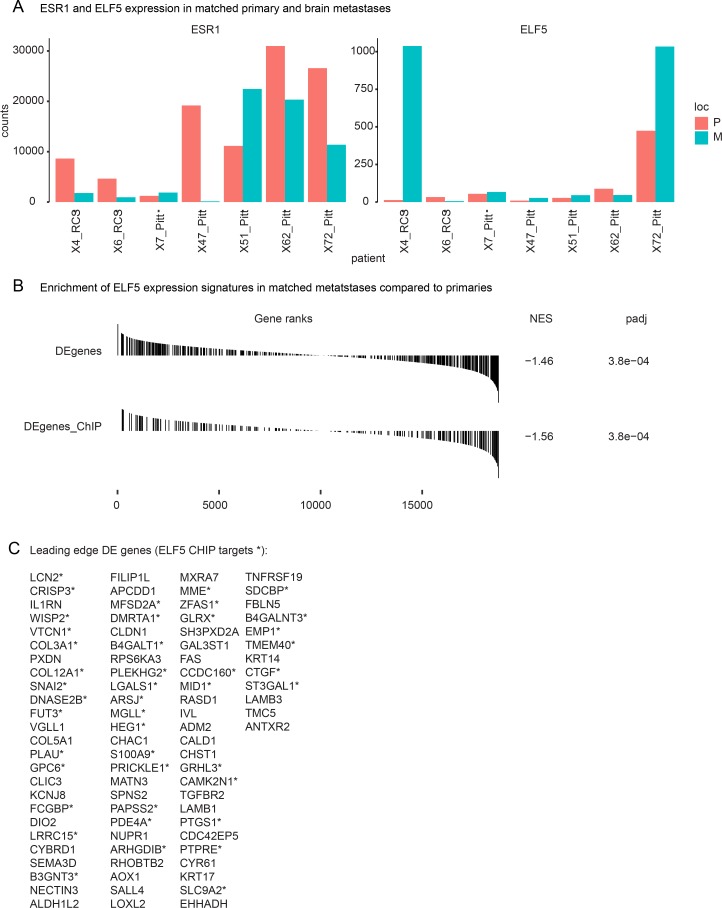
ELF5 expression is increased in endocrine resistant metastases.Panel A, levels of ESR1 and ELF5 expression in ER+ matched primary (P) and brain metastases (M) normalised from data produced by Vareslija and colleagues [50]. Panel B, GSEA determined enrichment (NES) of gene sets comprising genes differentially expressed in MCF-7 cells due to induction of ELF5 (DE) or a subset with an ELF5 ChIP binding site with 10kb (DEgenes_ChIP). Panel C, genes at the leading edge of the enrichments shown in panel B, asterisks indicate a gene that is also a transcriptional target of ELF5 by ChIP-seq.